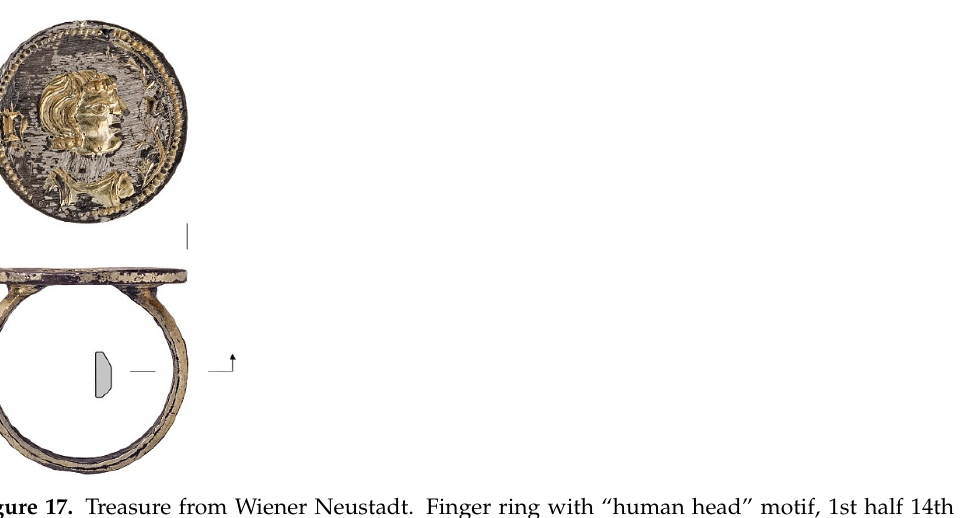
Figure 16. Treasure from Wiener Neustadt. Finger ring with “crescent moon and cross” motif, late 13th century. The motif is only visible here in the X-ray image, as the surface is heavily corroded. Photo: Paul Kolp; editing: Franz Siegmeth.